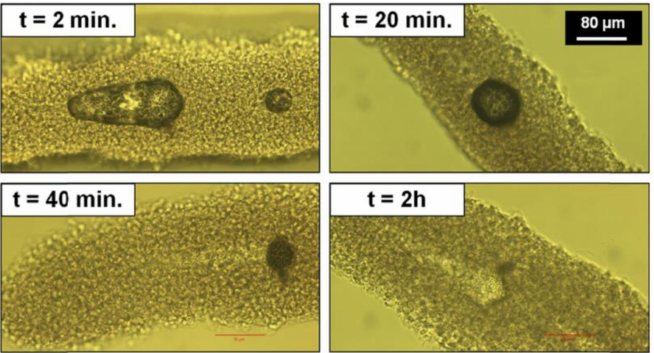
Figure 7. Temporal evolution of a laser-induced cavitation bubble inside the hydrogel core of a single microfibre. Inserts indicate the time elapsed since the end of laser